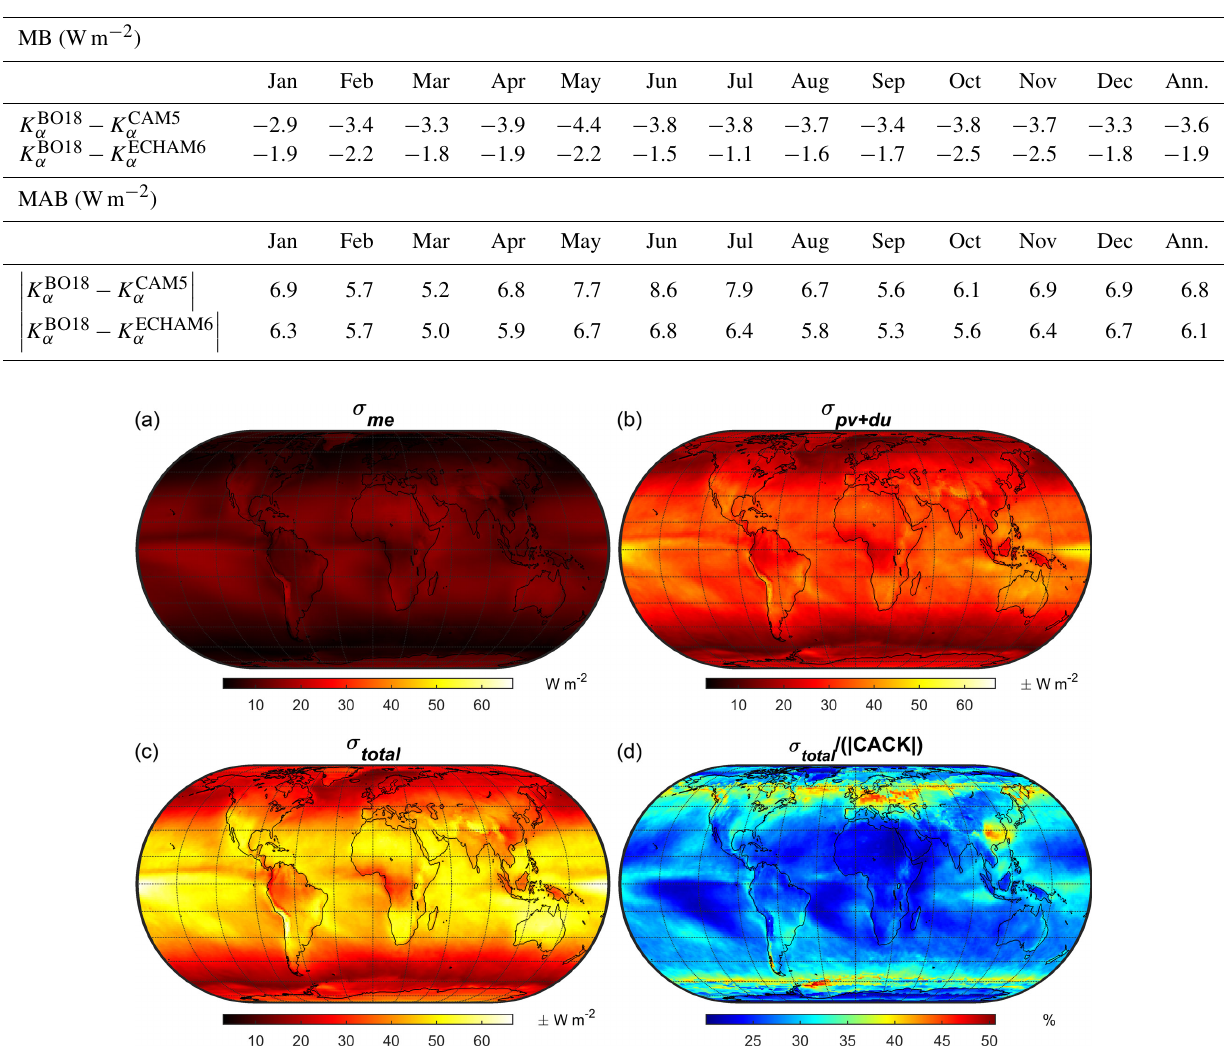
Figure 5. Annual uncertainty of a CACK based on 2001–2016 monthly mean CERES EBAF v4 climatology: (a) the absolute uncertainty related to model error (i.e., the parameterization); (b) the total propagated absolute uncertainty related to physical variability and data uncertainty of CACK input variables; (c) total absolute uncertainty; (d) total relative